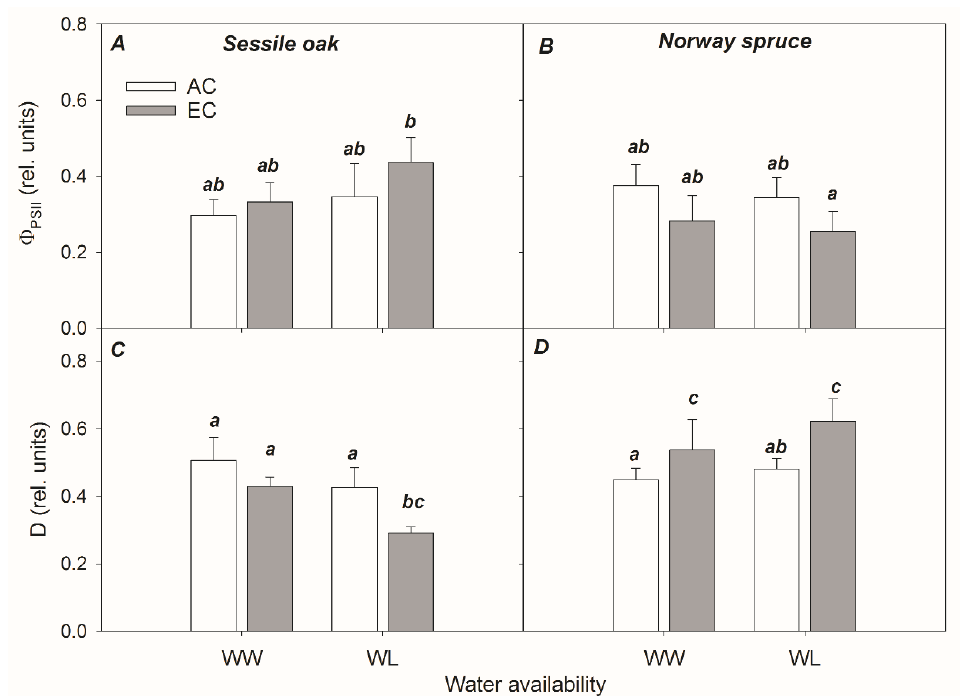
Figure 7. Effect of CO 2 concentration and water availability on actual quantum yield of PSII photochemistry ( Φ PSII; upper panels) and thermal energy dissipation (( D ); bottom panels) under saturating light intensity in sessile oak (left) and Norway spruce (right). Means (columns) and standard deviations (error bars) are presented ( n = 3). Different letters indicate significant differences ( p ≤ 0.05) between means based on Tukey’s ANOVA post-hoc test. AC—ambient CO 2 concentration (~400 μ mol CO 2 mol –1 ), EC—elevated CO 2 concentration (~700 μ mol CO 2 mol –1 ), WW—well-watered (regular watering of 20 mm per week during vegetation period), WL—water-limited (no irrigation for 5 weeks before the measurements).